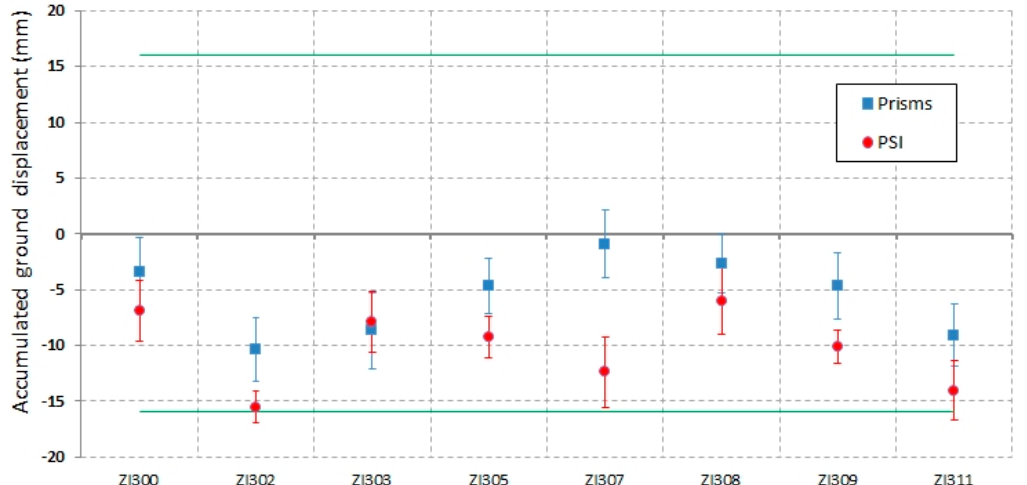
Figure 17. Accumulated displacement from 11 November 2015 to 15 May 2017 for prisms (robotic station) correspond to PS (closed to the prisms positions) and its related standard deviations in the Selinha dike. The error bar limits (±16 mm) are shown in green.